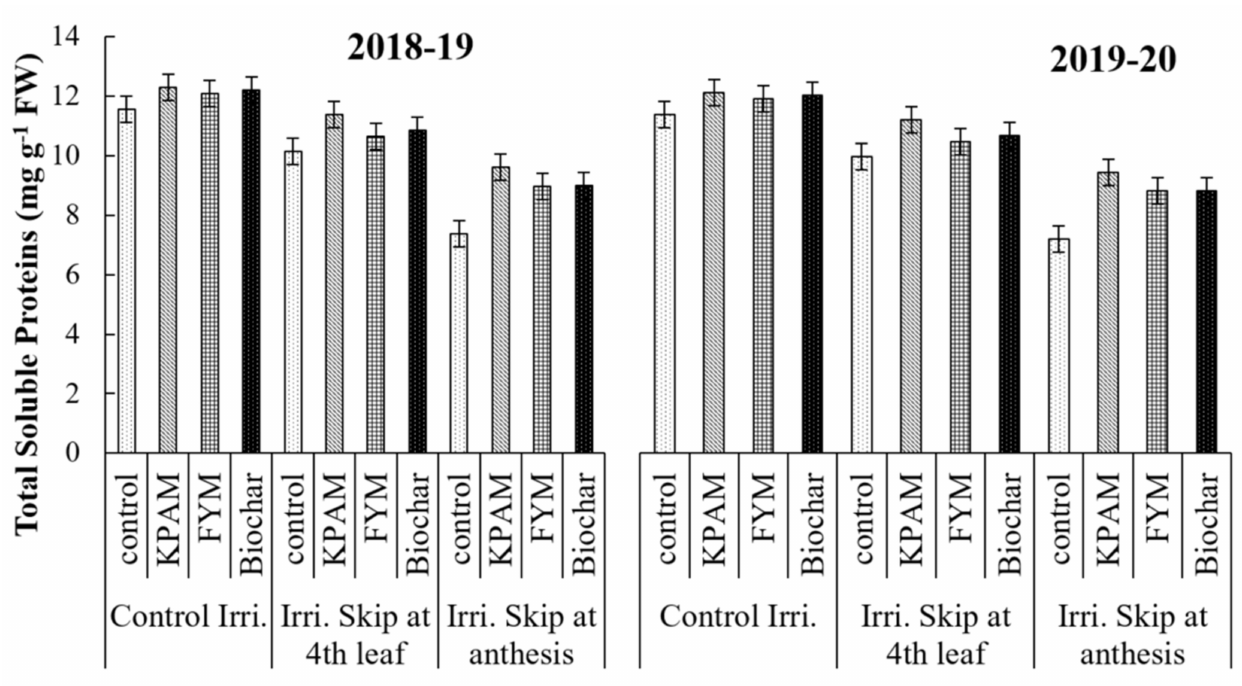
Figure 8. Effect of soil amendment materials on total soluble proteins in the wheat crops grown under normal and water stress imposed by skipping irrigation at 4th leaf and anthesis stage of growth (mean values ±